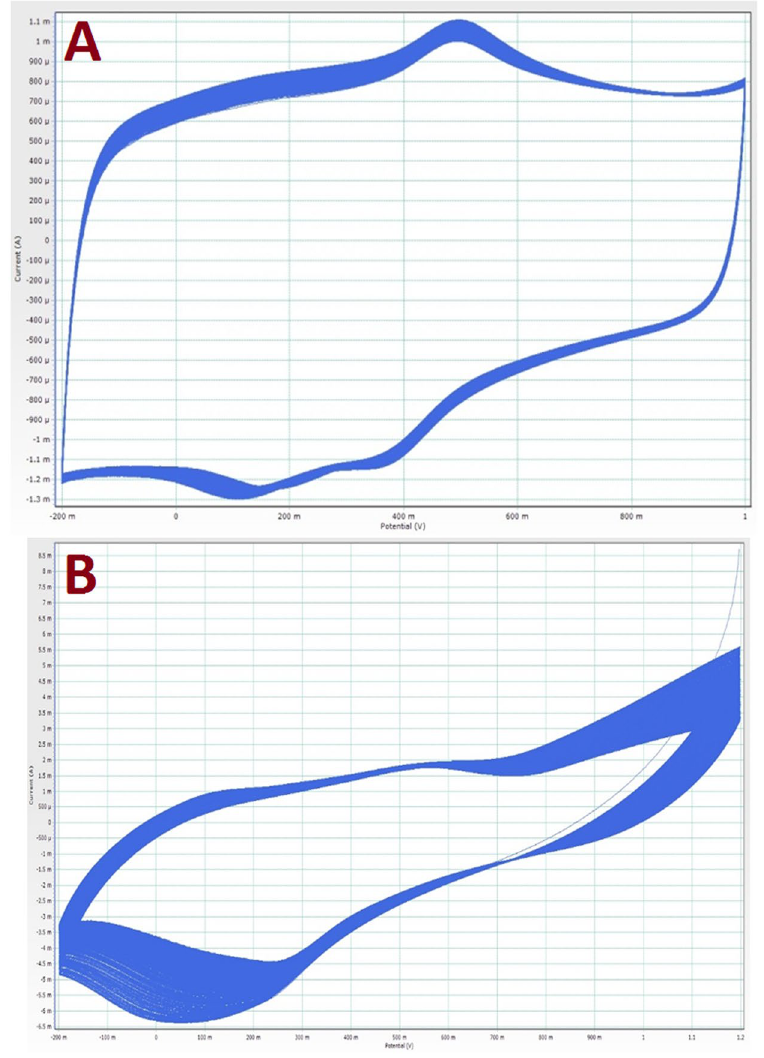
Figure 5. Screen shots for 1000 cycles in 0.5 H 2 SO 4 for the synthesized FeNi-N-Gr; ( A ) and Pt/C; ( B